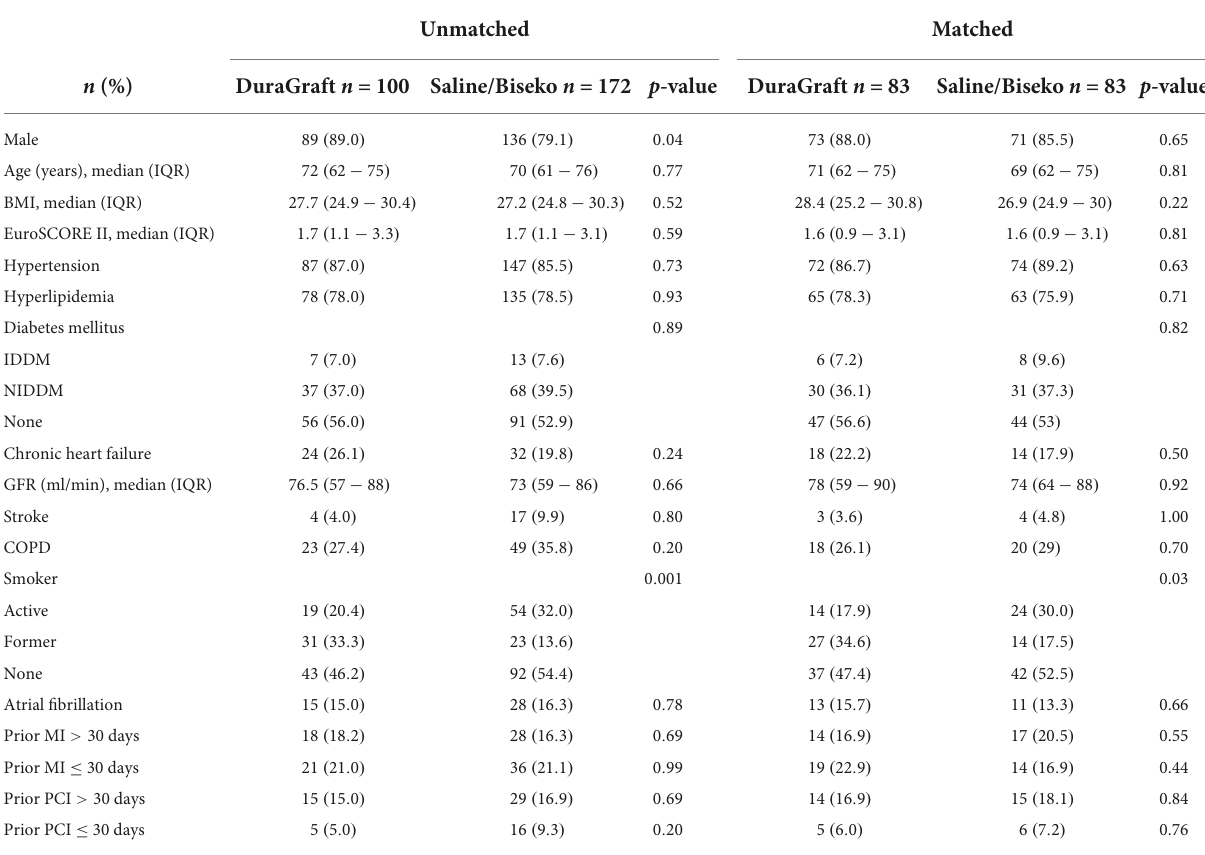
TABLE 1 Patient baseline